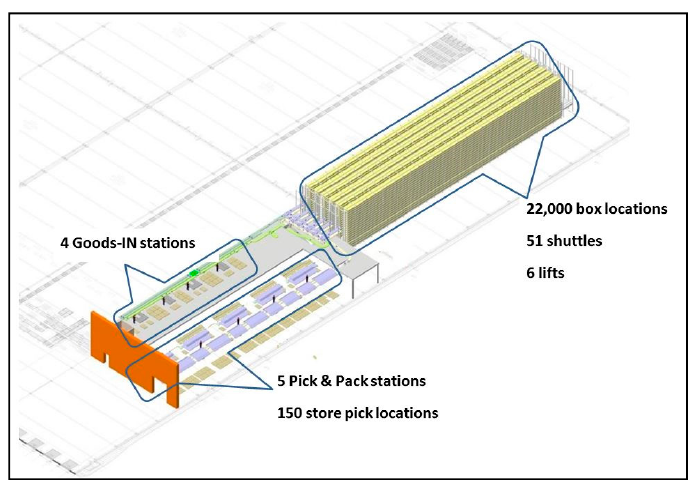
Figure 6. Box automation system general layout.